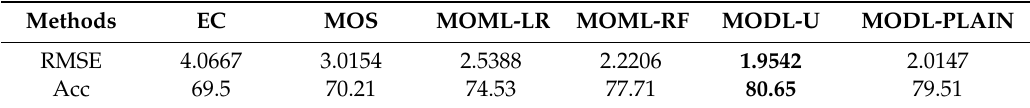
Table 3. Model performance on the test set.